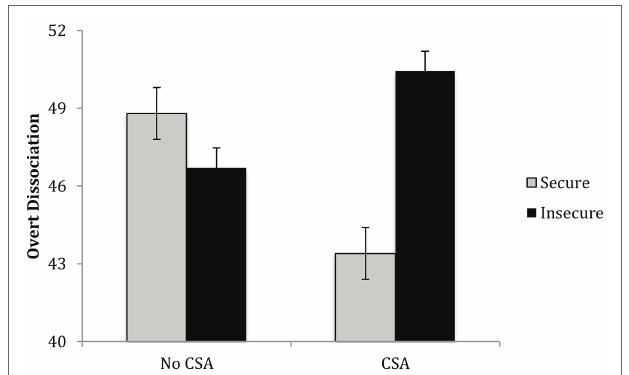
FIGURE 5 | Children’s CSA history and attachment interact in predicting their overt